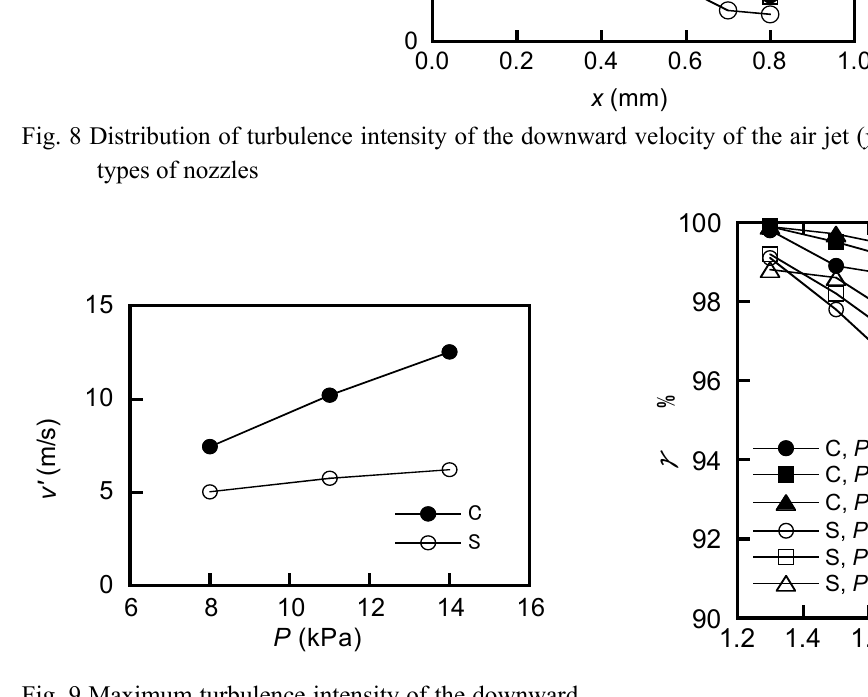
Fig. 10 Removal rate of particles (3 μ m) dependent on gap H measured by using the proposed cleaning system at various settings of pressure P